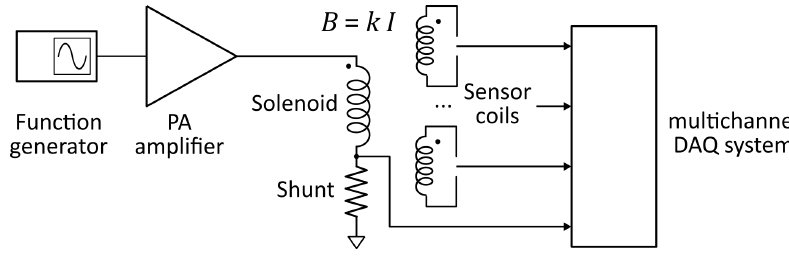
Figure 6. Realized electrical measurement setup.